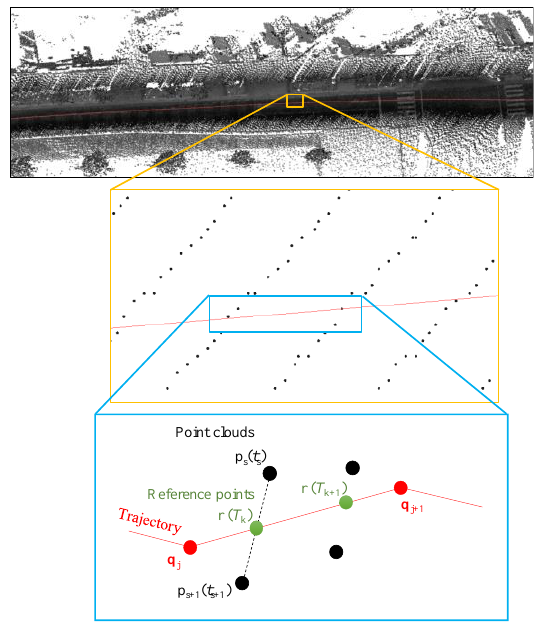
Figure 8. Intersection between a scan-line and a trajectory